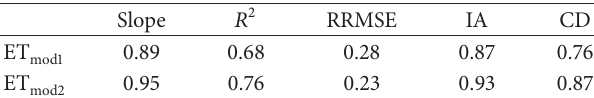
Figure6:SeasonalvariationinthemeasuredandsimulatedET(ET 𝑎 and ET mod ) for days without rain in 2005 using (9). Table 2: The validation statistics of the model simulated by the meteorological factors versus the model simulated by the meteoro- logical factors and biotic